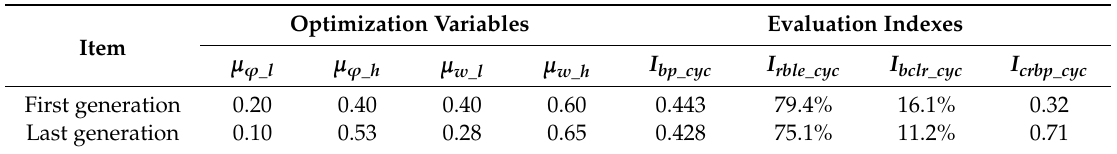
Table 3. Results of the